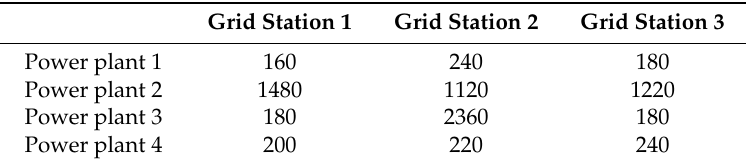
Table 4. Length of power transmission lines between plants and grid stations